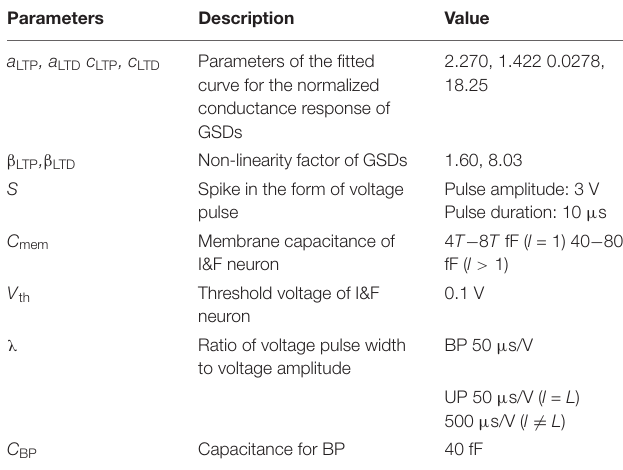
TABLE 1 | The parameters when the GSDs are used as synaptic devices in the